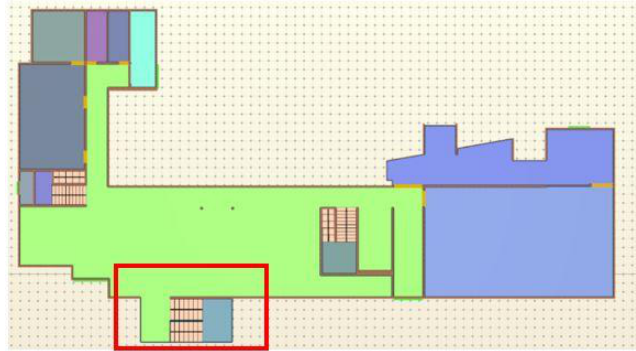
Figure 2. Ladders A and B configuration diagram in Scenario A.